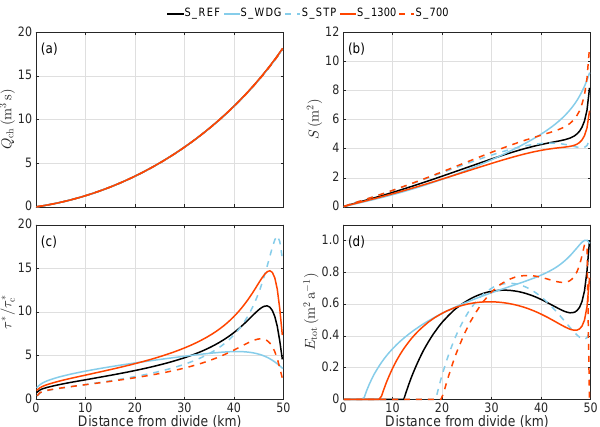
Figure 3. Comparison of steady-state simulations with varying ice geometries, reference water input and drainage through a single R- channel (Table 3). (a) Discharge in the channel, Q ch , (all curves overlap); (b) channel cross-sectional area, S ; (c) transport stage, τ ∗ /τ ∗ c ; and (d) total erosion computed with the TLEM ( E tot ).